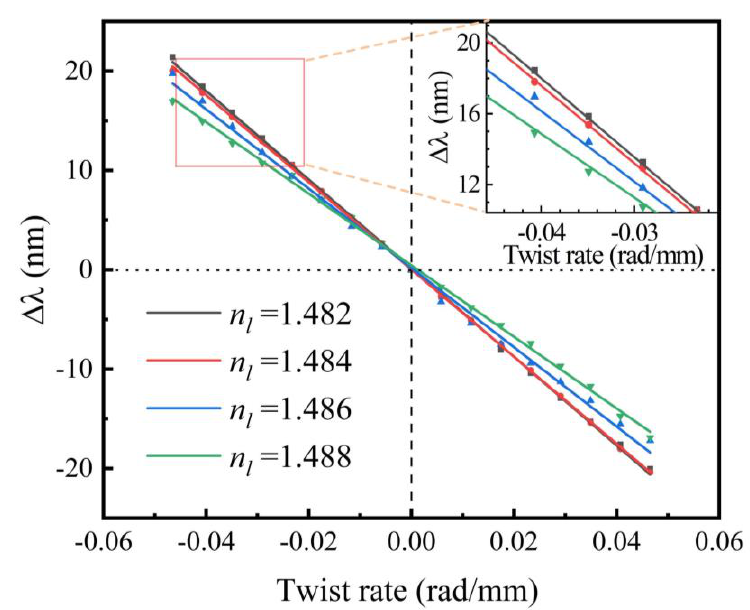
Figure 12. Linear fitting between the applied twist rate and wavelength shifts for the LFTPCFs filled with standard liquid with various RI. Table 2. Torsion sensitivities (ST) of the LFTPCFs with different standard RI liquid.